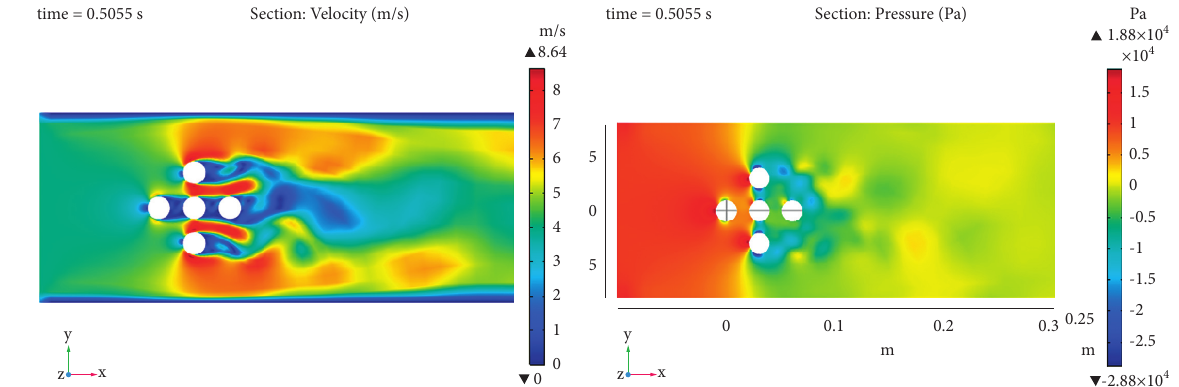
Figure 22: Velocity and pressure nephogram of XY section.